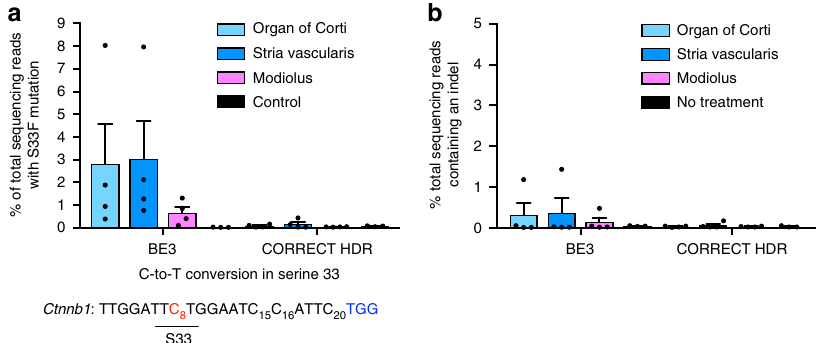
Fig. 5 In vivo S33F mutation of β -catenin induced by injection of base editor RNPs. a Tissue was harvested from the cochlea of mice injected with either BE3 + S33-targeting sgRNA, or with CORRECT HDR agents. HTS of genomic DNA isolated from tissue samples revealed the frequency of the S33F mutation. Note that because tissue samples contain cells not exposed to editing agents, the observed genome modi fi cation frequency in these samples is less than the editing ef fi ciency of treated cells. b Indel frequency at the Ser 33 locus following treatments described in a . Values and error bars re fl ect mean ± S.E.M. of four mice injected with BE3 and four mice injected with CORRECT HDR agents. Control samples in a , b are organ of Corti from